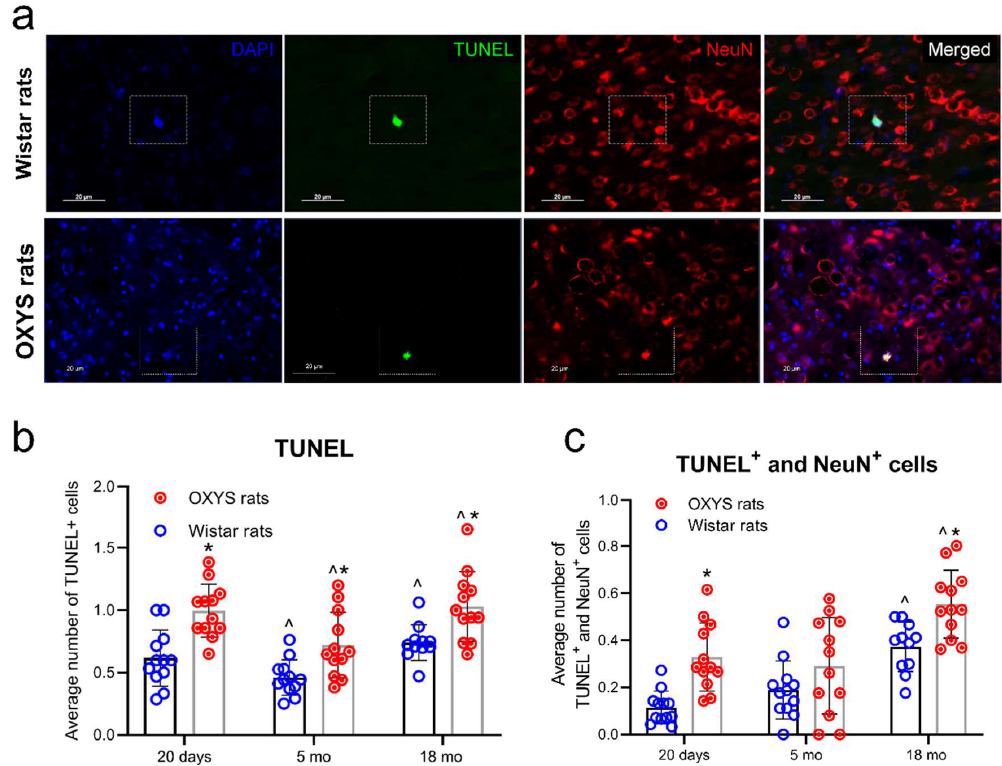
Figure 1. Apoptotic cell death. ( a ) Representative images of cortex cryosections (immunostained by the terminal deoxynucleotidyl transferase dUTP nick end labeling (TUNEL) method) from 18-month-old OXYS and Wistar rats. The TUNEL staining (green) and neuronal nuclear antigen (NeuN) staining (red) were examined under a fluorescence microscope, with subsequent quantitative analysis. The numbers of apoptotic cells ( b ) and apoptotic neurons ( c ) were calculated by averaging the numbers of TUNEL signals. Data are presented as mean ± SD, n = 4 (with three sections per animal). * Interstrain di ff erences, ˆ age-associated di ff erences; p < 0.05.